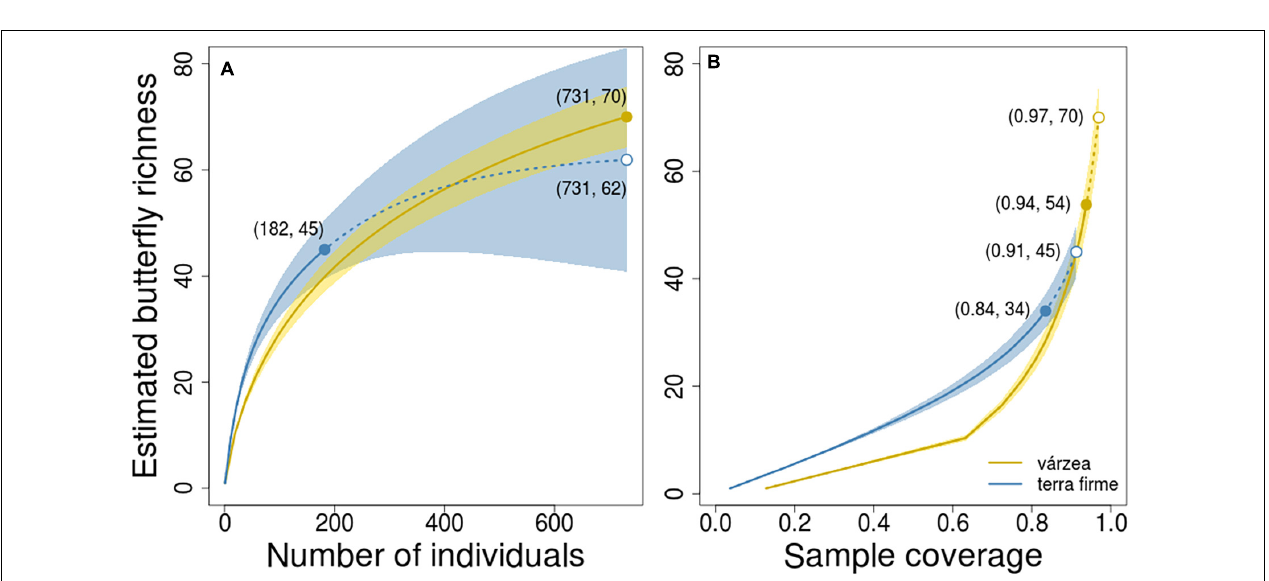
FIGURE 2 | Butterfly counts and number of species in várzea and terra firme forest plots. Difference in butterfly counts (A) and number of species (B) per plot between the two forest types. Square, circle and triangle symbols represent plots in Baixo Juruá, Mamirauá and Amanã reserves, respectively. (C) Assemblage rank-abundance distribution from the two forest types.